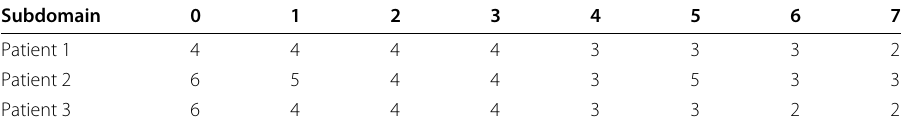
Table 3 Number of points distributed in the individual subdomains. The corresponding decay of subspace angles is depicted in Fig. 8, the point distributions in Fig.